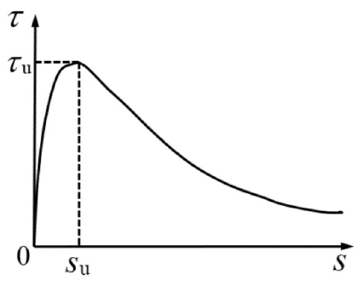
where, β is the shape coefficient of descending stage of the bond stress-slip curves.